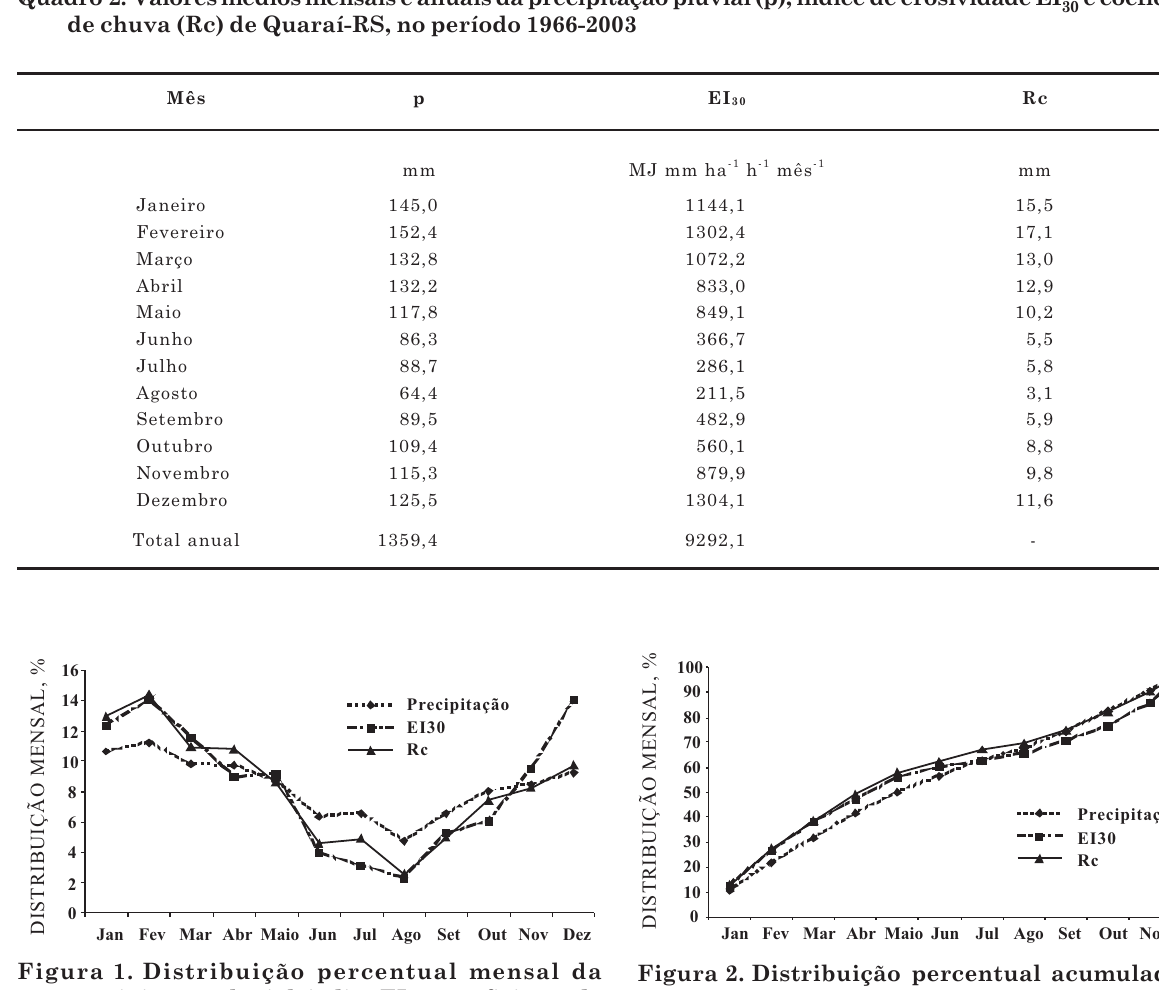
Quadro 2. Valores médios mensais e anuais da precipitação pluvial (p), índice de erosividade EI